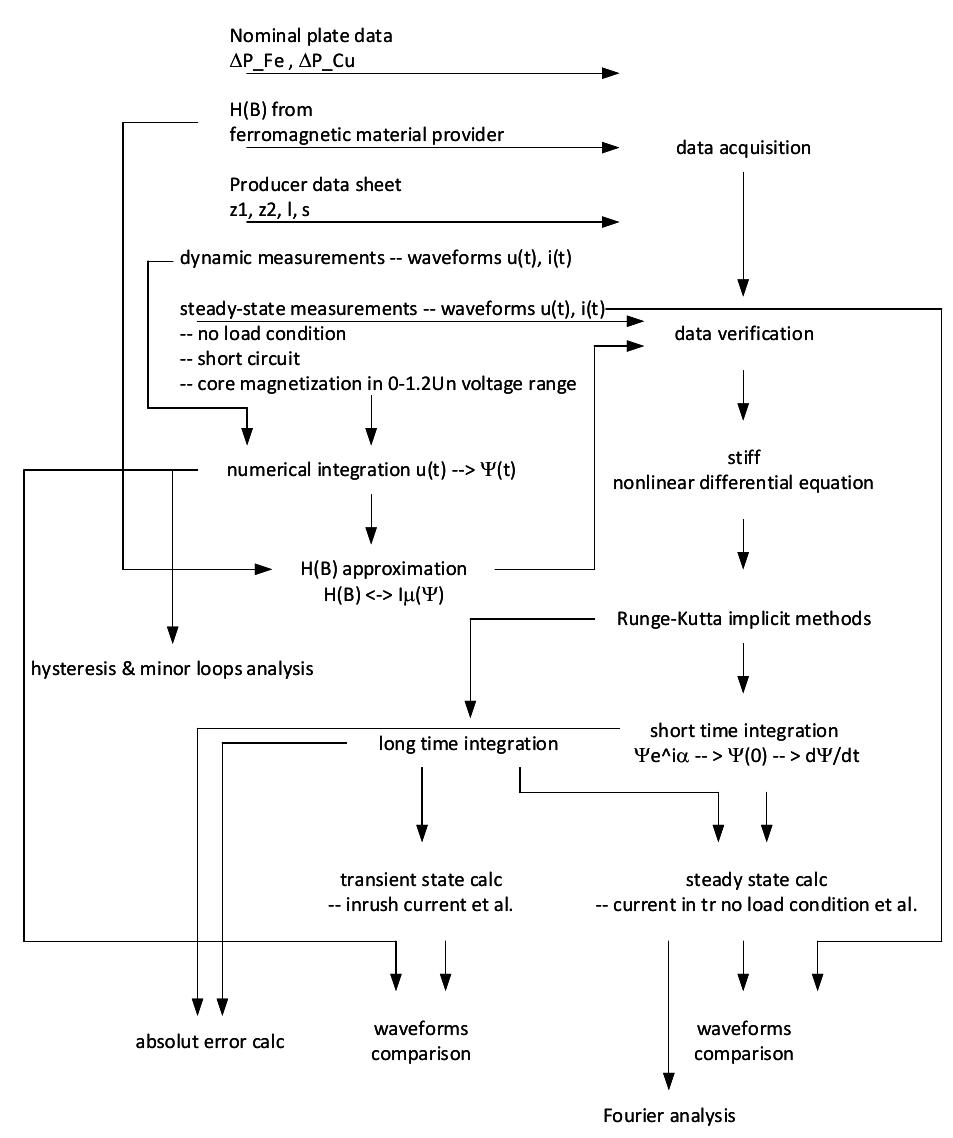
Figure 5. Diagram of the